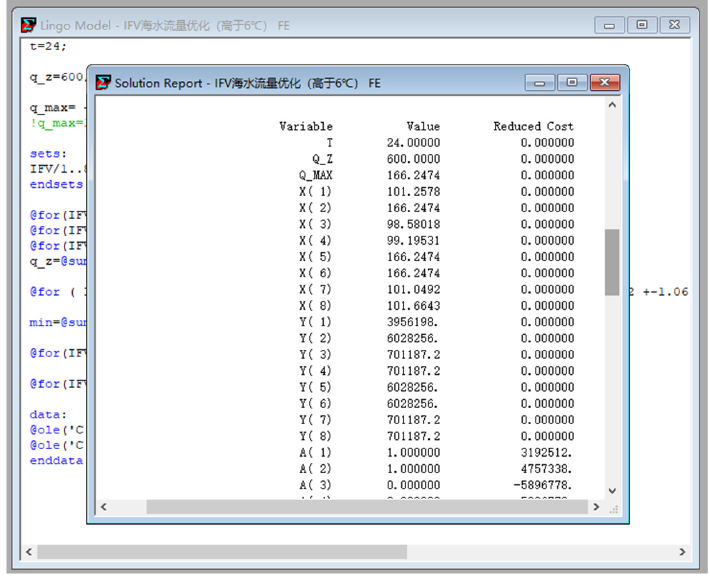
Figure 19. Software calculation results interface.